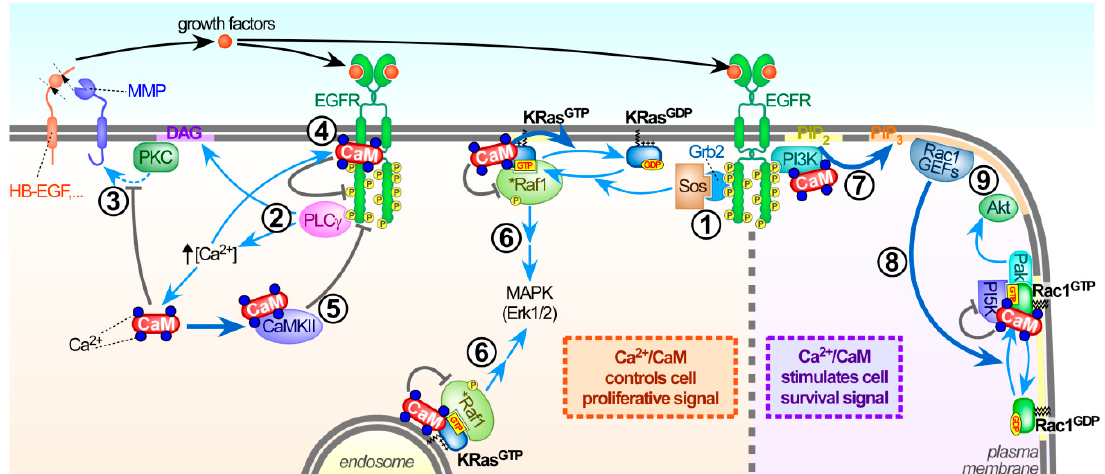
Figure 2. Model of key signalling events modulated by Ca 2 + / calmodulin and decisive for cell proliferation and survival. In this scheme, key signalling events regulated by calmodulin (CaM) and critical for cell proliferation (left) and cell survival (right) are highlighted. Left: Several protein–protein interactions of calmodulin enable a negative feedback regulation of the mitogen-activated protein kinase (MAPK) extracellular signal-regulated kinase 1 / 2 (Erk1 / 2). This signalling cascade is initially activated by epidermal growth factor receptor (EGFR), and other receptor tyrosine kinases not shown here, at the cell surface and prolonged on endosomes. The overall outcome of these interactions prevents a strong and sustained signal that promotes cell proliferation. Right: Calmodulin can activate phosphoinositide-3 kinase (PI3K) and through protein kinase B (Akt) and Rac1, ensure the generation of signals that stimulate cell survival. Key interactions and signalling events are numbered and underscore the following: ( 1 ) Growth factor (e.g., EGF) ¡-induced EGFR activation and autophosphorylation enables the recruitment of adaptors (Grb2) and guanine nucleotide exchange factors (Sos). This is followed by activation of the Ras / Raf1 / MAPK signalling pathway. ( 2 ) Simultaneously, phospholipase C γ (PLC γ ) is recruited to activated EGFR to produce the second messenger diacylglycerol (DAG) and elevate cytosolic Ca 2 + levels. ( 3 ) The latter binds and activates calmodulin, which disables DAG-dependent and protein kinase C (PKC)-mediated activation of matrix metalloproteases (MMPs). This prevents the shedding and release of membrane-bound growth factor precursors, such as heparin-binding EGF (HB-EGF). This regulatory circuit e ff ectively prevents prolonged EGFR activation in an autocrine manner. ( 4 ) In addition, Ca 2 + / calmodulin binds EGFR and inhibits its tyrosine-kinase activity. ( 5 ) Moreover, Ca 2 + / calmodulin binds Ca 2 + / calmodulin-dependent kinase II (CaMKII), which has the ability to phosphorylate and inactivate EGFR. These multiple interactions suggest a negative feedback mechanism that allows Ca 2 + -induced calmodulin activation to trigger downregulation of EGFR signalling. ( 6 ) Furthermore, Ca 2 + / calmodulin may preferentially interact with active KRas (KRas-GTP), which is particularly relevant in settings where KRas is the most prominent Ras family member contributing to MAPK activation, such as in NIH3T3 fibroblasts. In these cells, KRas / calmodulin interaction blocks downstream Raf1 activation. This could possibly be accompanied by the recruitment of GTPase activating proteins (GAPs) that further reduce KRas-GTP levels, thereby advancing to downregulate MAPK signalling and proliferation in these cells. ( 7 ) On the other hand, Ca 2 + / calmodulin together with activated EGFR can stimulate PI3K activity. ( 8 ) This increases the recruitment and activity of Rac1 guanine nucleotide exchange factors (Rac1 GEFs) that elevate Rac1-GTP (active) levels. ( 9 ) Together with Akt activation, these signalling events are linked to an anti-apoptotic response that triggers cell survival. The GTP / GDP cyles of KRas and Rac1, as well as the membrane location of phosphatidyl-4,5-biphosphate (PIP 2 ) and phosphatidylinositol-3,4,5-triphosphate (PIP 3 ) are indicated. In summary, Ca 2 + / calmodulin modulates the MAPK pathway driving proliferation and on the other hand, stimulates PI3K activity to induce cell survival. The overall biological outcome probably depends on the signal diversity derived from the extracellular milieu as well as the cell-specific and di ff erential repertoire of calmodulin-responsive players in each